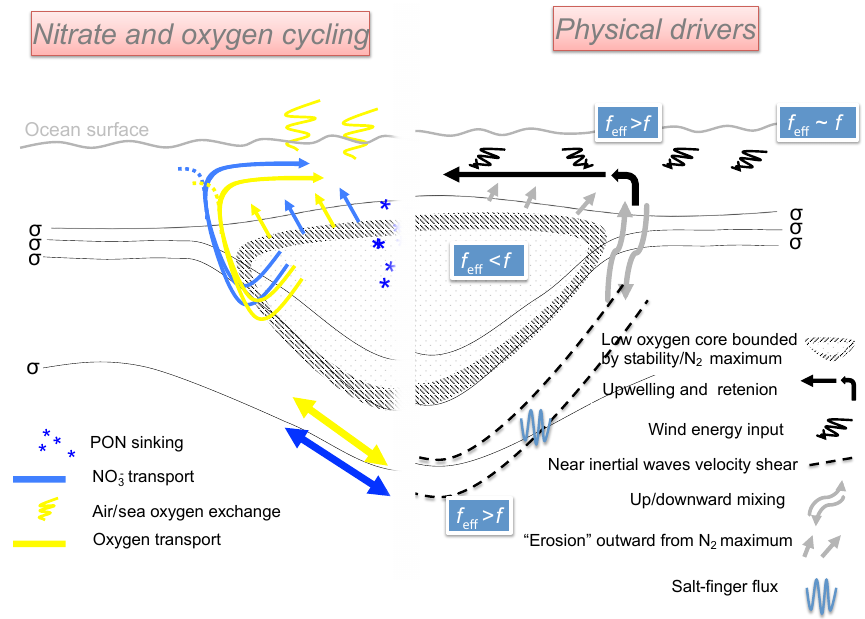
Figure 8. Conceptual view of the biogeochemical (left) and physical (right) processes responsible for creating a low oxygen ACME. The recycling of nitrate is decoupled from the oxygen cycling through PON. The transport at the flanks and the isolation of the eddy core are linked to the energy propagation of NIW. Vertical flux (upwelling and downwelling) of nutrient rich/low oxygen waters occurs at the boundaries and at the mixed layer base (outward). Eddy retention keeps upwelling waters in the euphotic zone of the eddy. Shear from NIW velocity fluctuations creates critical Ri underneath the eddy core with thermohaline anomalies that favour salt-finger type double